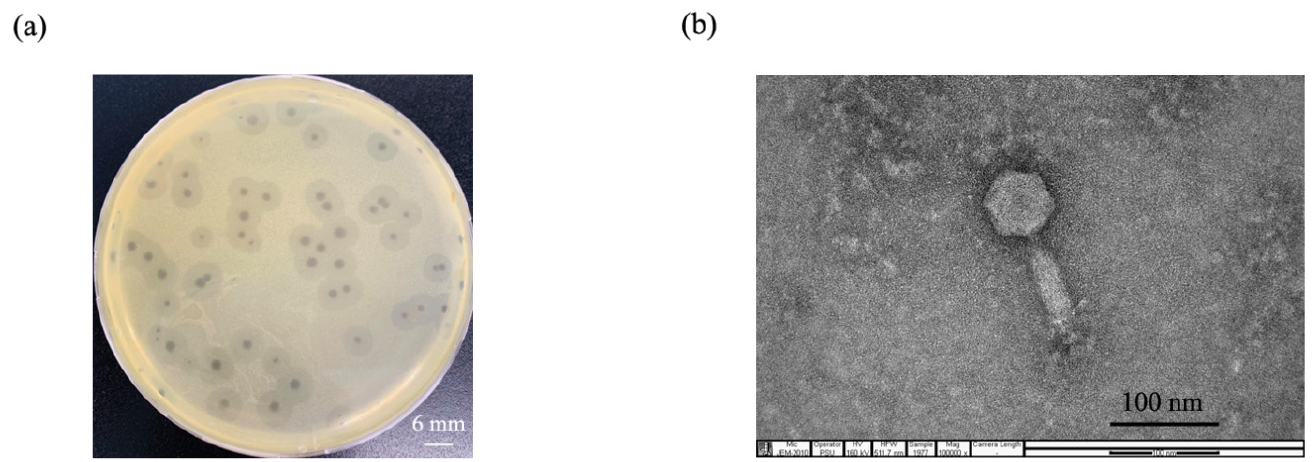
Figure 1. Phage isolation and morphological characterization of the phage particle. ( a ) Morphology of phage vWUPSU plaques. The conventional double-layer agar method was performed to observe plaque morphology. MDR A. baumannii NPRCOE 160519 was used as the host strain. The plaques were observed and photographed after incubation at 37 ◦ C overnight. The scale bar represents 6 mm; ( b ) phage morphology under transmission electron microscope (TEM). Phage particles were stained by a negative staining technique and visualized under JEOL JEM-2010 TEM at an acceleration voltage of 160 kV (100,000 × magnification). The scale bar represents 100nm.